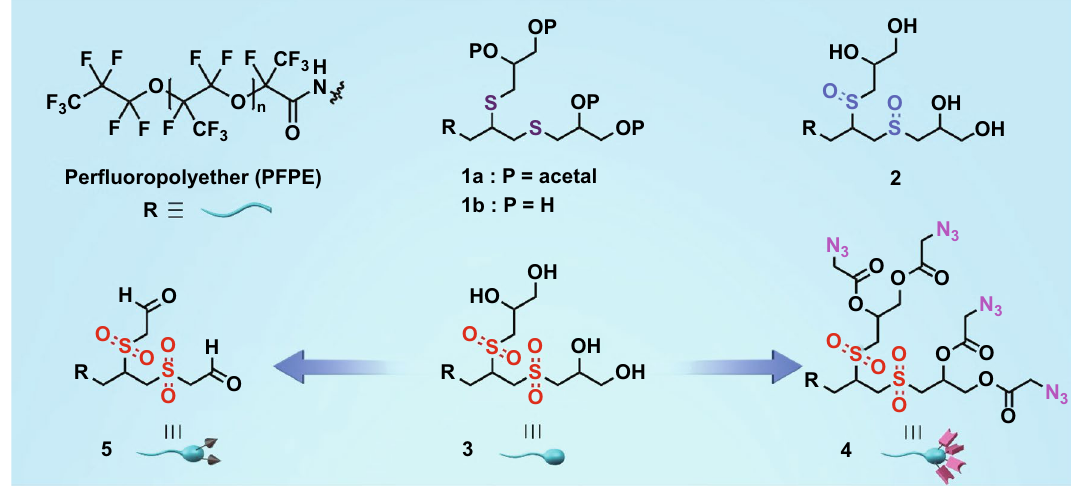
Fig. 1 Functional surfactants The perfluoropolyether tail R is identical in surfactants 1a, 1b , 2 , 3 , 4 , and 5 . Surfactant 1a has multiple thioethers and the 1,2‑diols are acetal protected (parent surfactant). Surfactants 1b , 2 , and 3 contain multiple thioethers, sulfoxides, and sulfones, respec‑ tively, with four hydroxyl groups in each of them. Surfactant 3 was functionalized to create surfactant 4 with azido‑moieties, while surfactant 5 with aldehyde groups was prepared by oxidizing the 1,2‑diols in